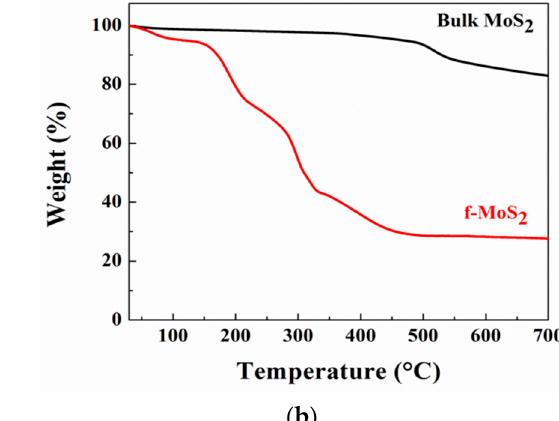
Figure 3. Confocal images of bulk MoS 2 and exfoliated f-MoS 2 nanoplatelets excited from 400–700 nm range (Blue to Far-red).